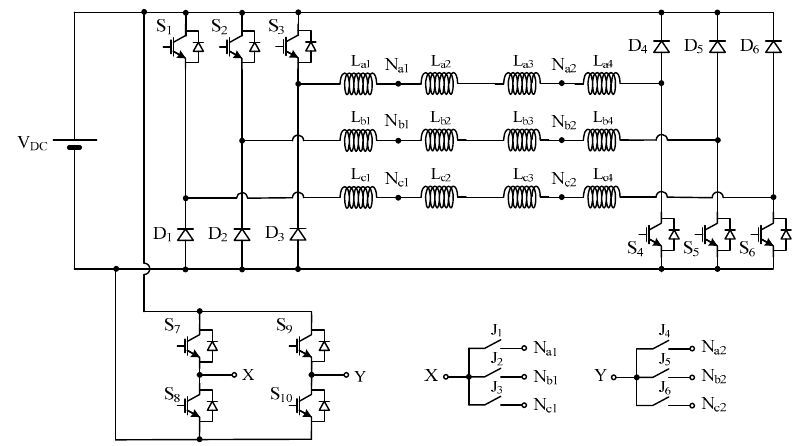
Figure 30. Fault-tolerant topology proposed by [95], which uses an additional classic single-phase full-bridge (four controlled power semiconductors) combined with six mechanical relays for three-phase SRM with split